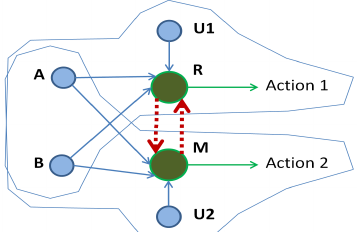
Figure 3: Neural circuit with 2 mutually inhibitory sub-